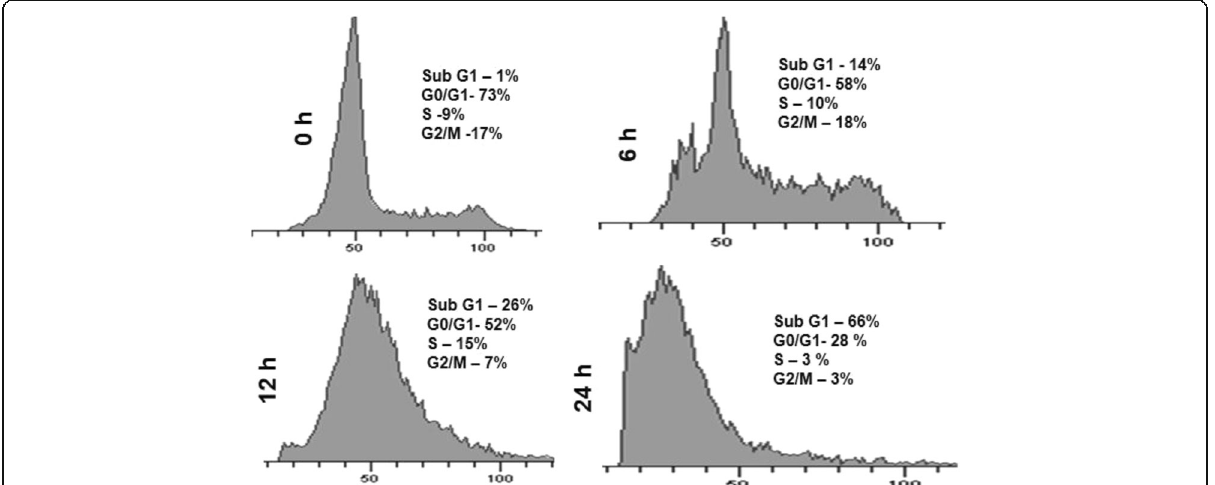
Fig. 3 Effects of SNME on cell division cycle of asynchronously growing NCI/ADR-RES cells. Cells were treated with 125 μ g/ml of methanolic extract for 0, 6, 12 and 24 h, stained with propidium iodide and analyzed by flow cytometry for DNA content. An increase in Sub G 0 phase indicated DNA fragmentation, a prerequisite for